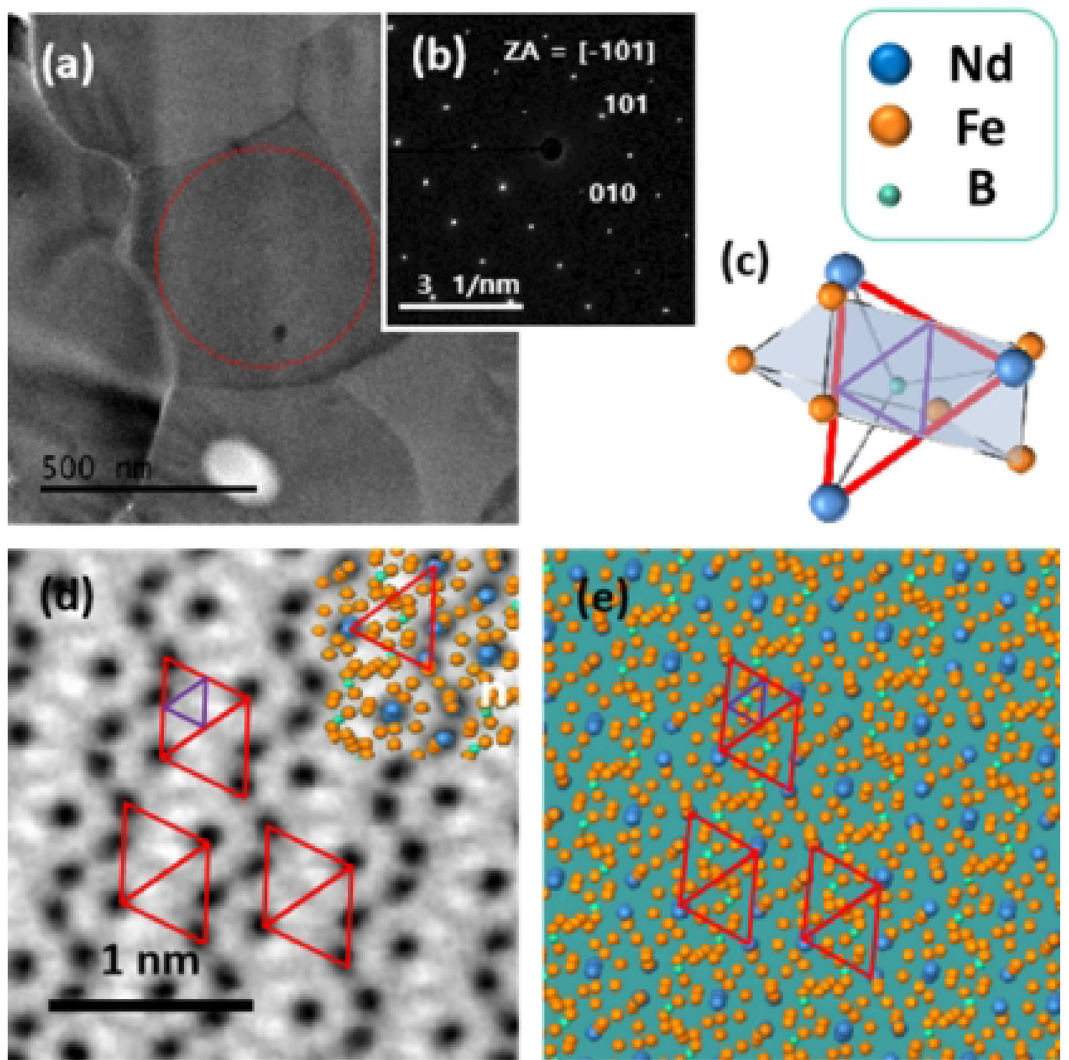
Figure 3. ( a ) TEM image of the Nd 1.5 Dy 0.5 Fe 14 B, ( b ) SAED pattern taken from the red circle in ( a ), ( c ) Nd 2 Fe 14 B trigonal prism in the [− 101] viewing zone axis, ( d ) high resolution BF-STEM image of Nd 1.5 Dy 0.5 Fe 14 B at [− 101] zone axis and ( e ) simulation of arrangement of the atoms by JEMS